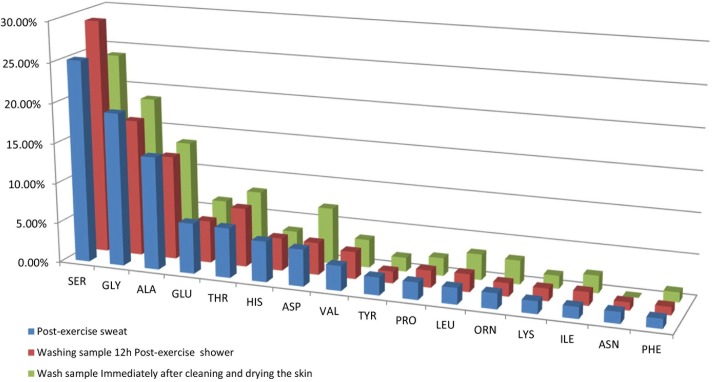
Comparison of the relative (percentage) abundances of amino acids in (a) post-exercise sweat, (b) a water-washing taken after 12 hours rest following a post-exercise shower and (c) a water-washing taken immediately after showering and drying. Values are averages from three separate sampling events from one male participant.